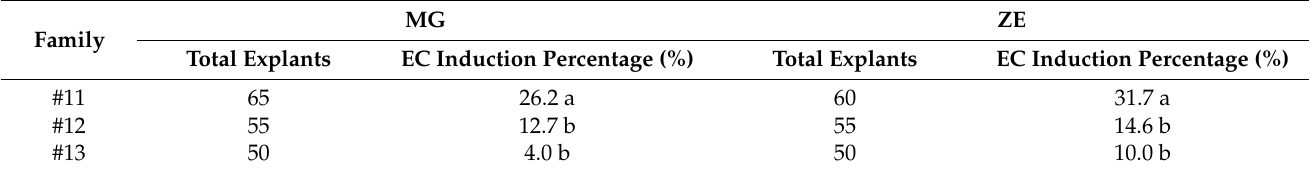
Figure 3. EC induced from MGs and ZEs as explants of Korean pine. ( a ) EC induced from MG explants. Scale = 1 cm. ( b ) EC induced from ZE explants. Scale = 1 cm. The letters ec stand for embryogenic callus; the letters mg stand for megagametophyte; and the letters ze stand for zygotic embryo. Table 6. E ff ects of explant types on EC induction percentage of Korean Pine.